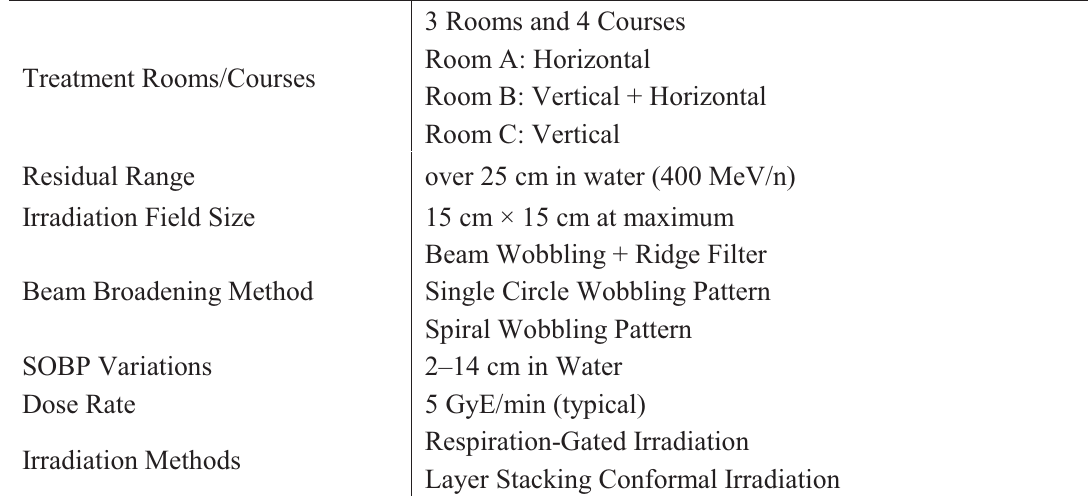
Table 1. The basic specifications of the beam delivery